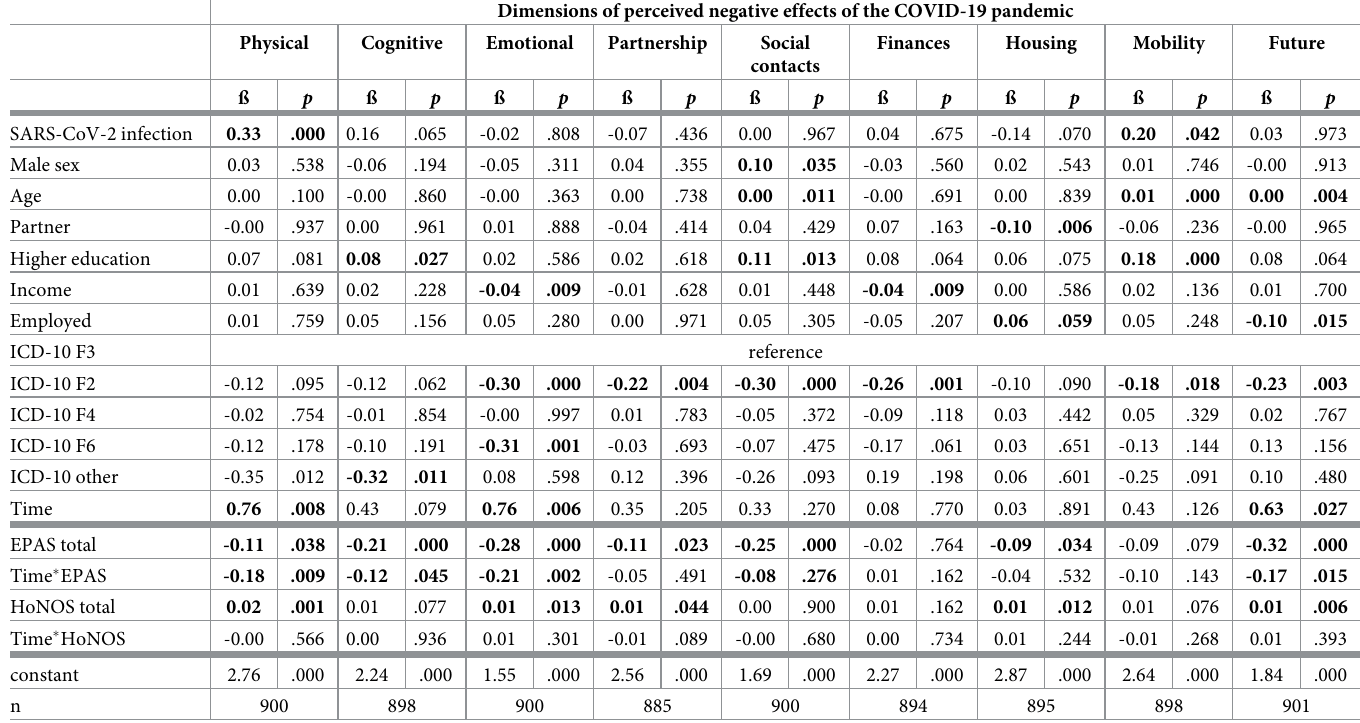
Table 2. Mixed effects regression models for the perceived negative effects of the COVID-19 pandemic (standardized regression coefficients and p -values). Dimensions of perceived negative effects of the COVID-19